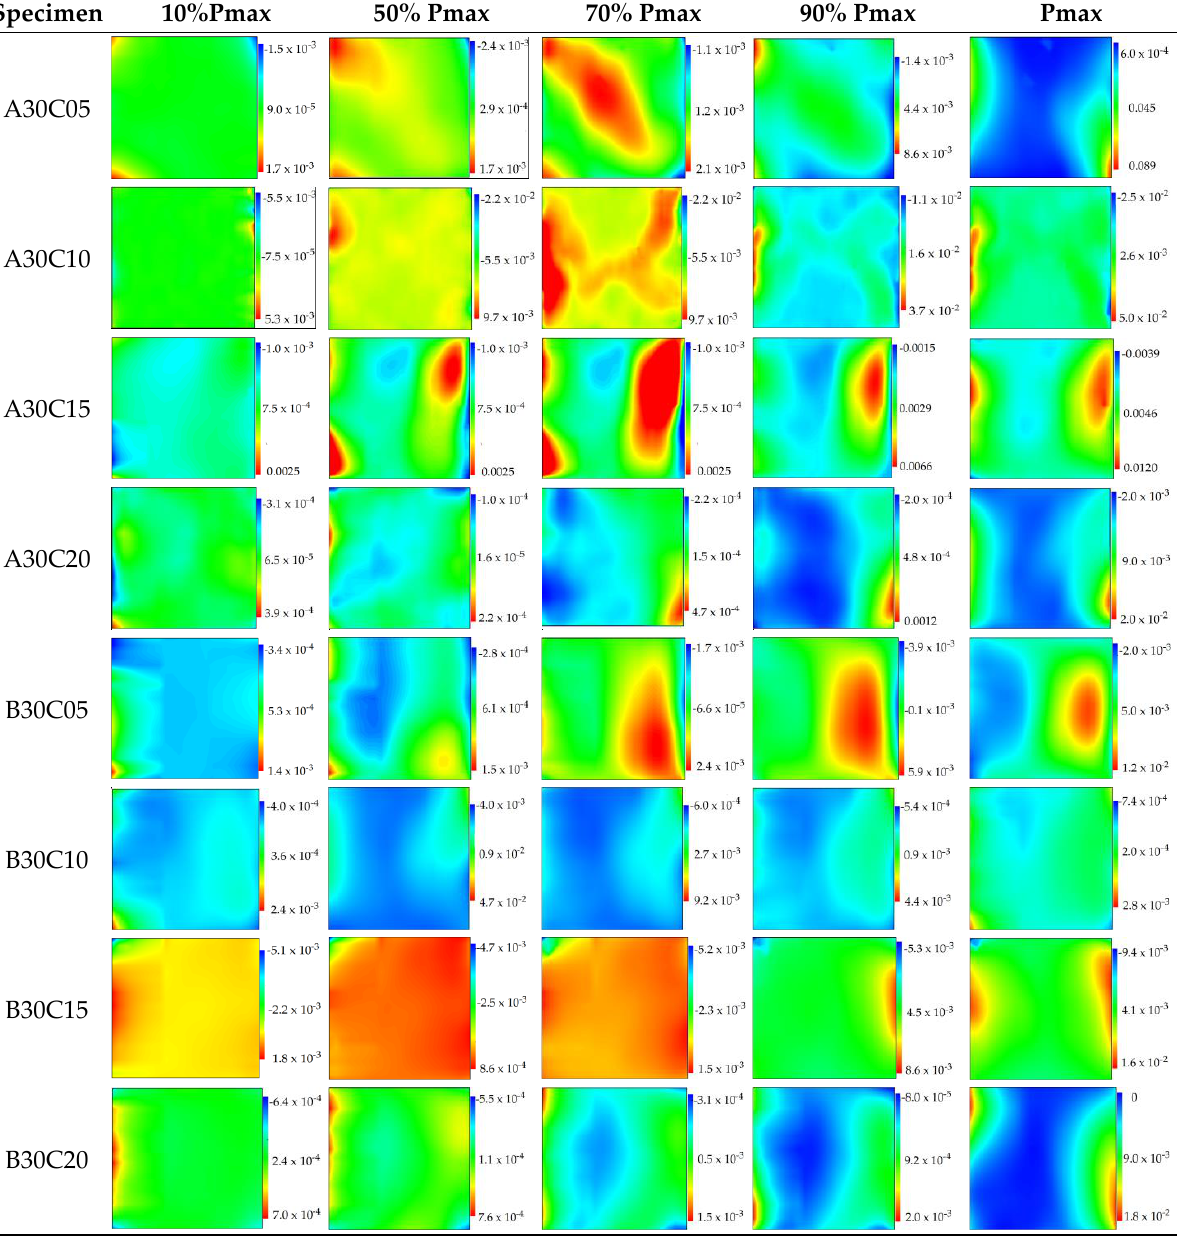
Figure 7. Evolution of horizontal strain field of PNFRC specimens.